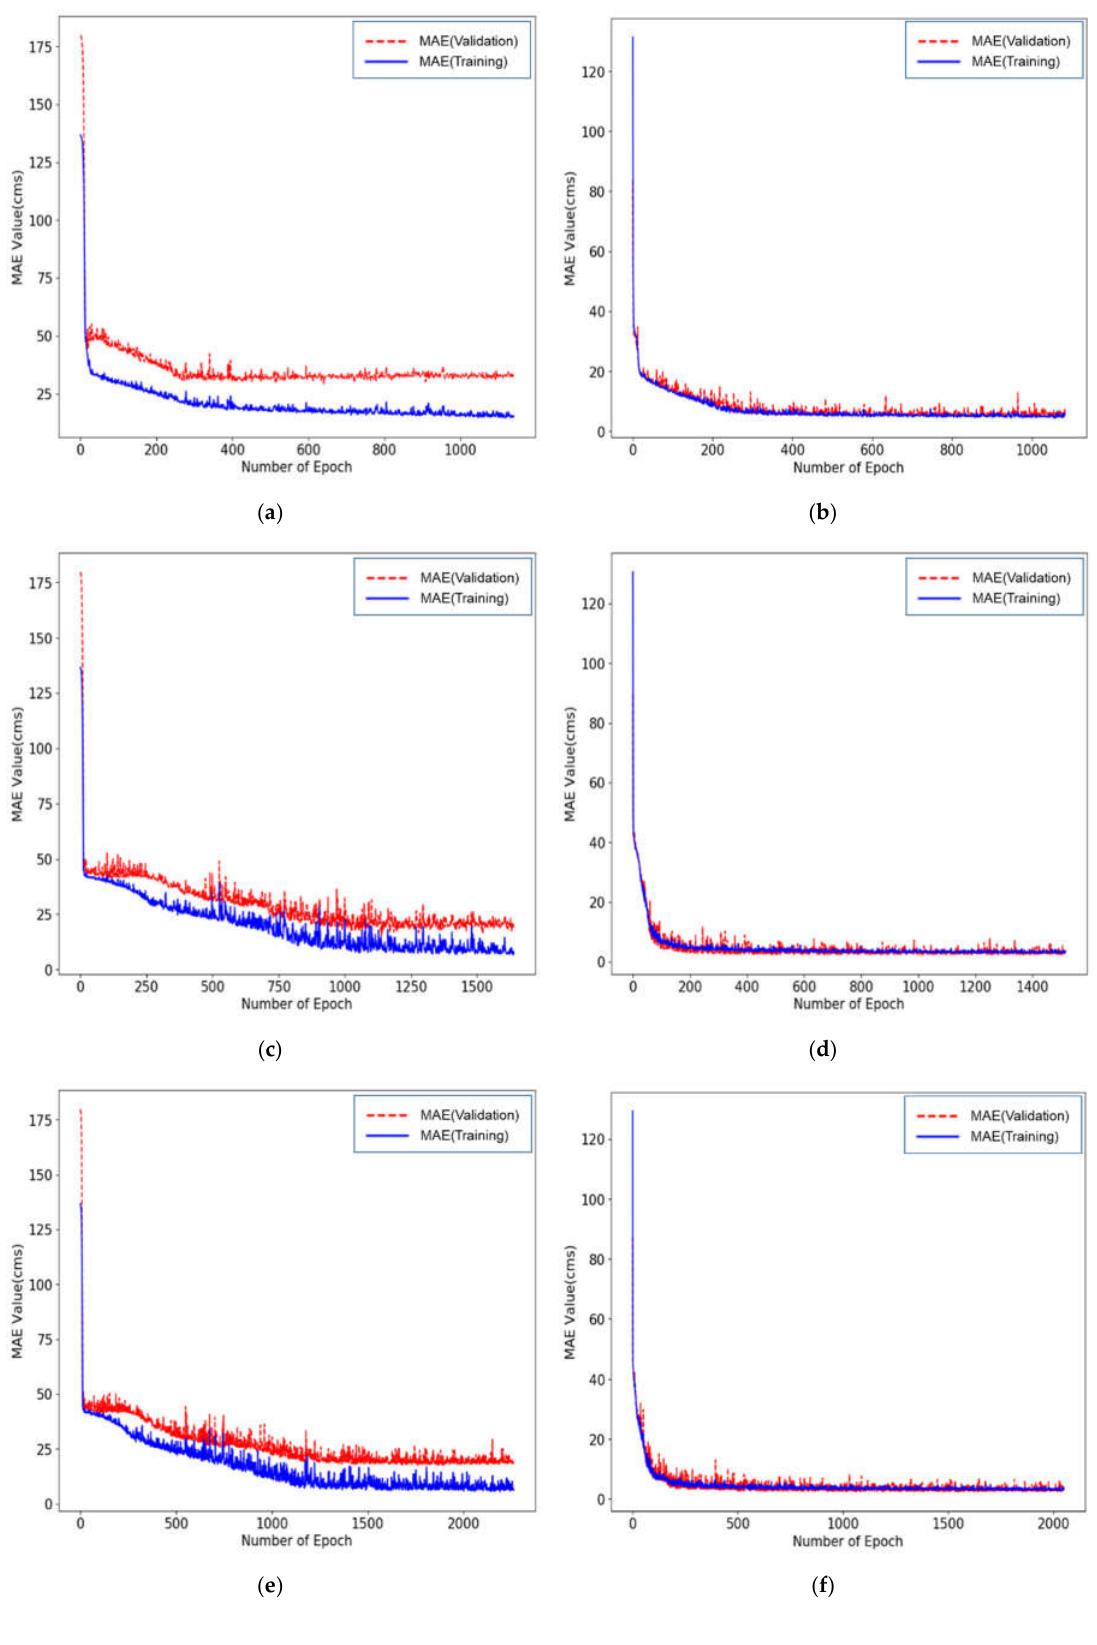
for the validation data set, and the blue solid line shows the error graph for the training data set. Each graph shows that after applying data augmentation, predictive power is improved not only for the training data set for the DL model, but also for the validation data set as well. In other words, the data augmentation technique improves the analysis result of validation data, rather than simply over‐ fitting with the training